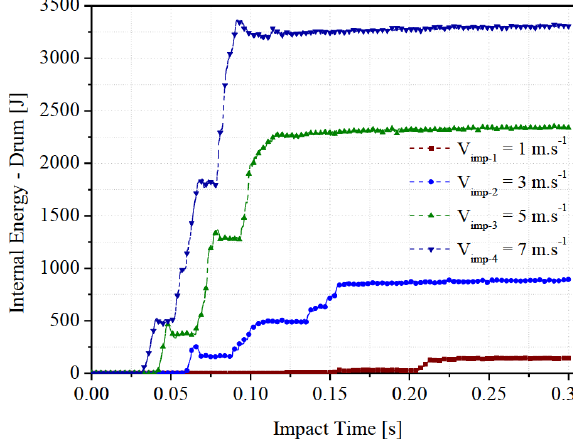
Figure 11: Global system velocity in impact: vertical direction (z- axis)